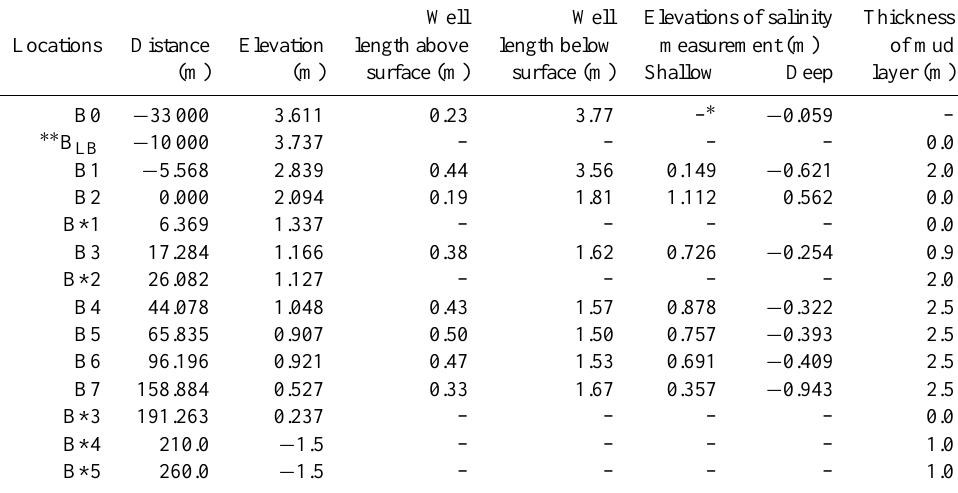
Table 2. Locations and depths of wells at the bald beach transect B-B 0